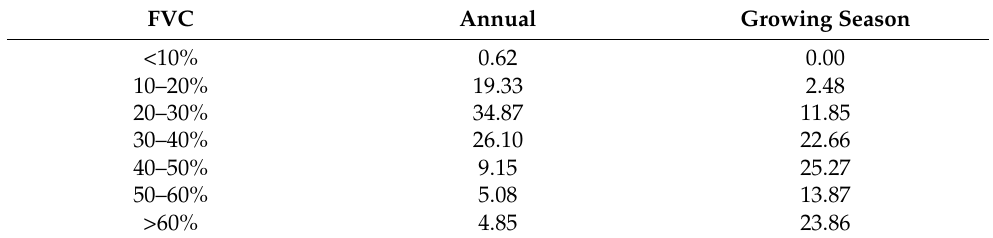
Table 1. Percentage of coverage area for different FVC for annual and growing season mean.